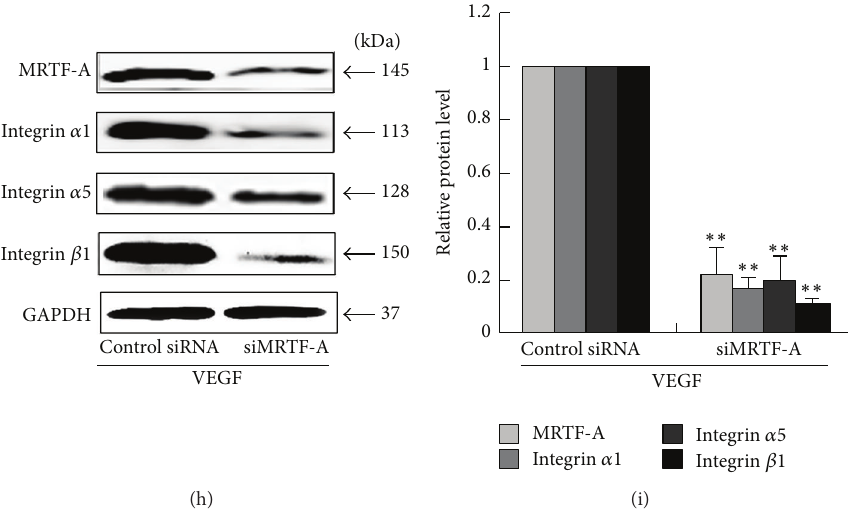
Figure 5: Knocking-down MRTF-A obstructed angiogenesis and migration in HUVECs by affecting integrin expression. (a) Western blotting confirmed the inhibition of endogenous MRTF-A in HUVECs transfected with siMRTF-A. (b) The capillary-like structures formed by HUVECs were observed on Matrigel. (c) Quantification of the capillary-like structures. ∗∗ 𝑃 < 0.01 , 𝑛 = 3 . The migratory ability of HUVECs transfected with siMRTF-A or control siRNA was determined by wound healing (d) and transwell chamber assays (e). (f) Cell migration was quantified by calculating relative cell numbers. ∗ 𝑃 < 0.05 , 𝑛 = 3 . (g) After transfection with siMRTF-A or control siRNA, HUVECs were treated with VEGF for 24h, and the expression of integrins 𝛼 1, 𝛼 5, and 𝛽 1 was then estimated by real-time PCR. ∗∗ 𝑃 < 0.01 , 𝑛 = 3 . (h) Western blotting for integrins 𝛼 1, 𝛼 5 and 𝛽 1. (i) The relative quantification of the protein expression. ∗∗ 𝑃 < 0.01 , 𝑛 = 3